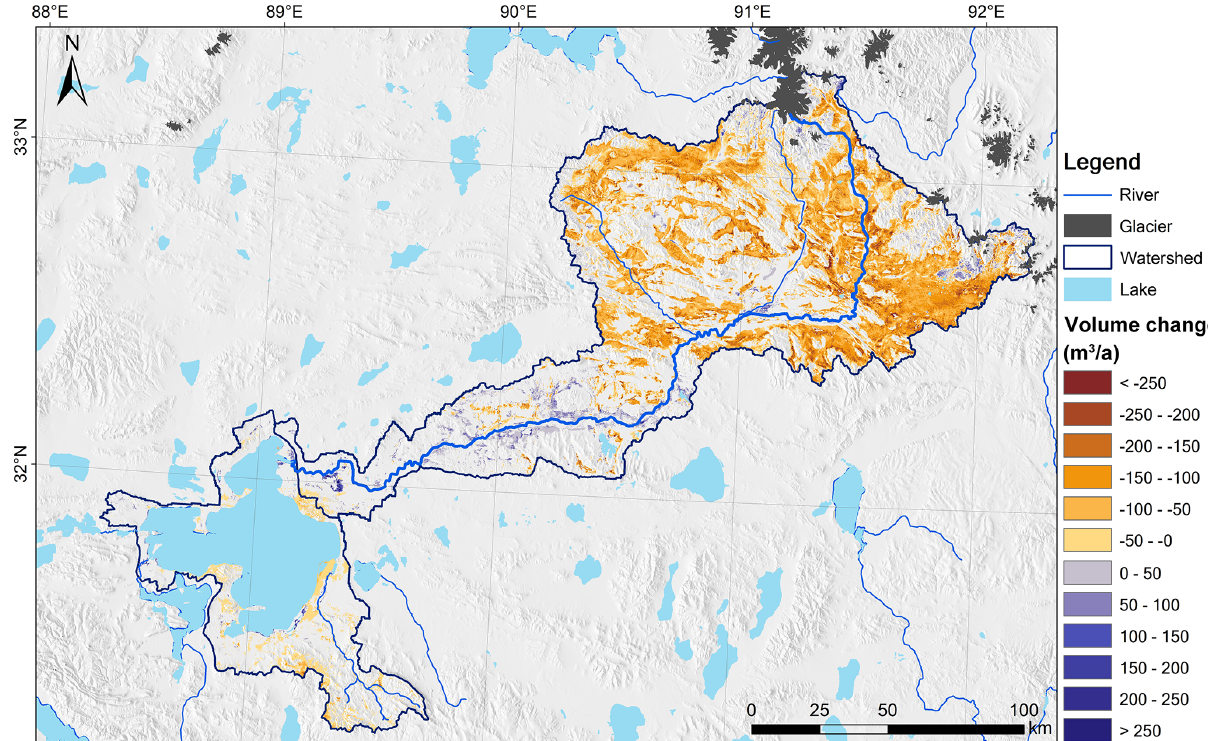
Figure 8. Map of the potential ground ice melting water supply. The grid color represents the grid cell’s yearly ground ice melting water supply volume, with negative values indicating ground ice loss and meltwater release.